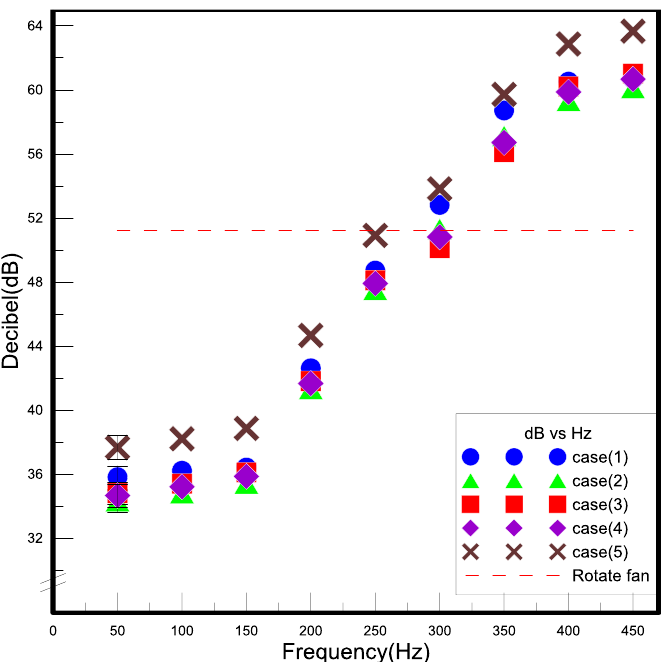
Figure 9. The results of noise measurement.